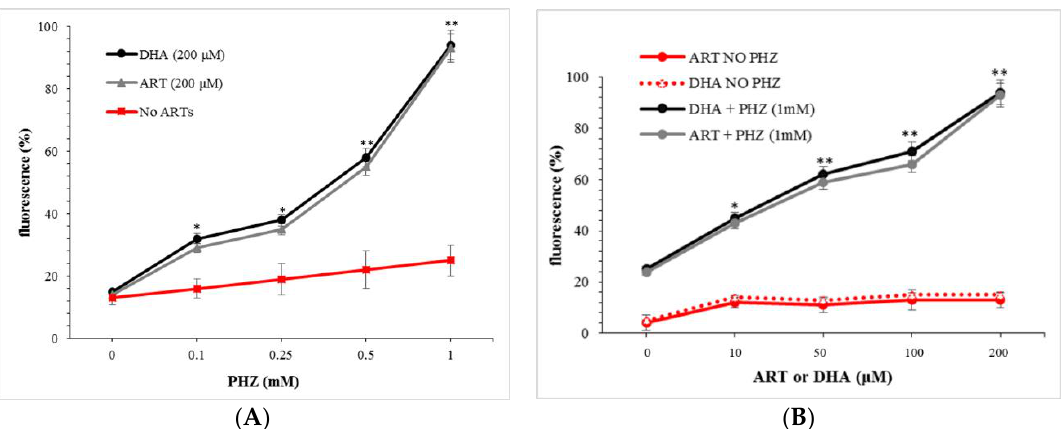
Figure 1. Reactive oxygen species (ROS) levels measured using CM-H 2 DCFDA. ( A ) Red blood cells (RBCs) treated with a fix concentration of artemisinin (ART) and dihydroartemisinin (DHA) (200 μΜ) after pre-treatment with PHZ (0.1–1 mM) and ( B ) RBCs pre-treated with 1 mM PHZ and then ART or DHA (10–200 μΜ). Data are the average ± SD of 5 independent experiments. Significant differences to untreated RBCs at * p < 0.05; ** p < 0.001.